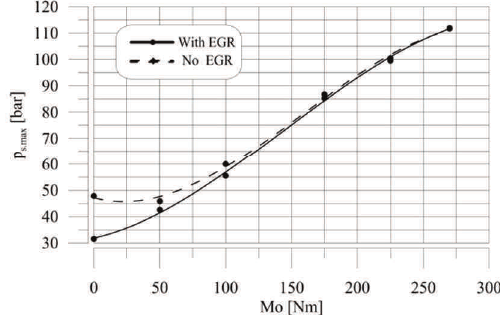
Fig. 6. Influence of the engine load on max pressure inside engine cylinder for engine operating with/without EGR